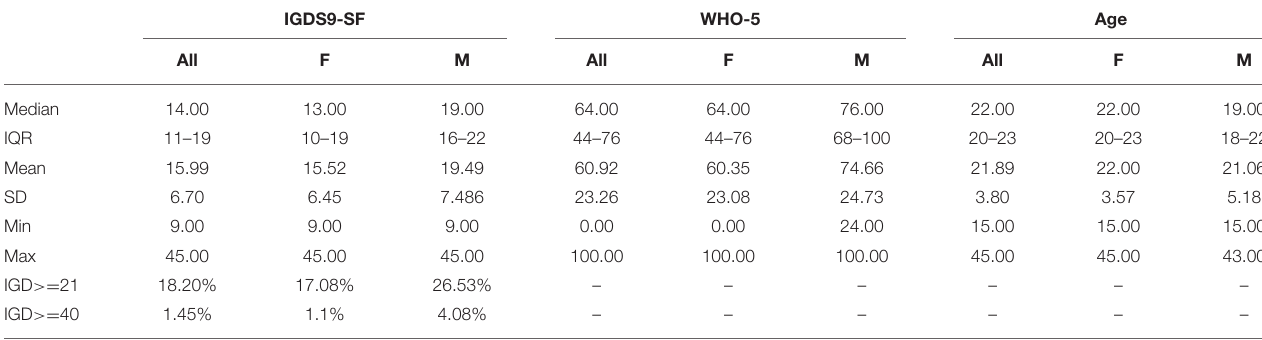
TABLE 1 | Descriptive statistics by gender for the study’s key